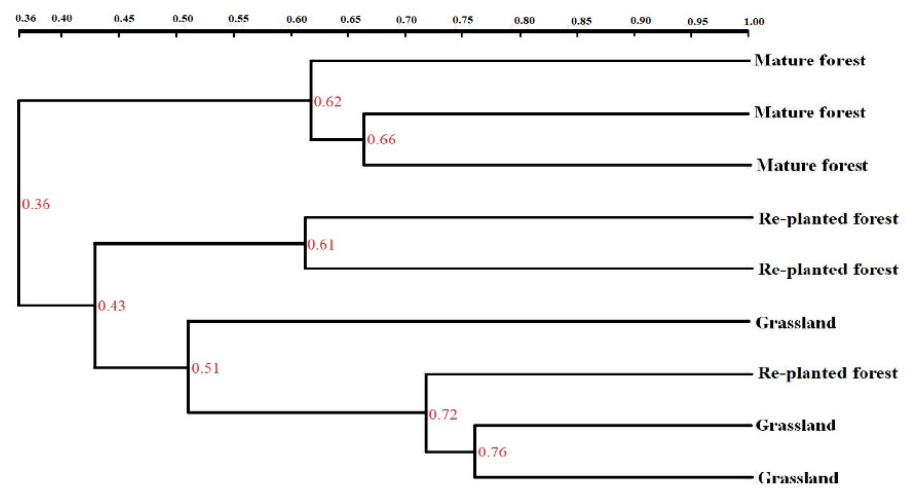
Figure 3. Cluster analysis of soil bacterial community structure under three types of vegetation measured by the unweighted pair group method with arithmetic mean (UPGMA).